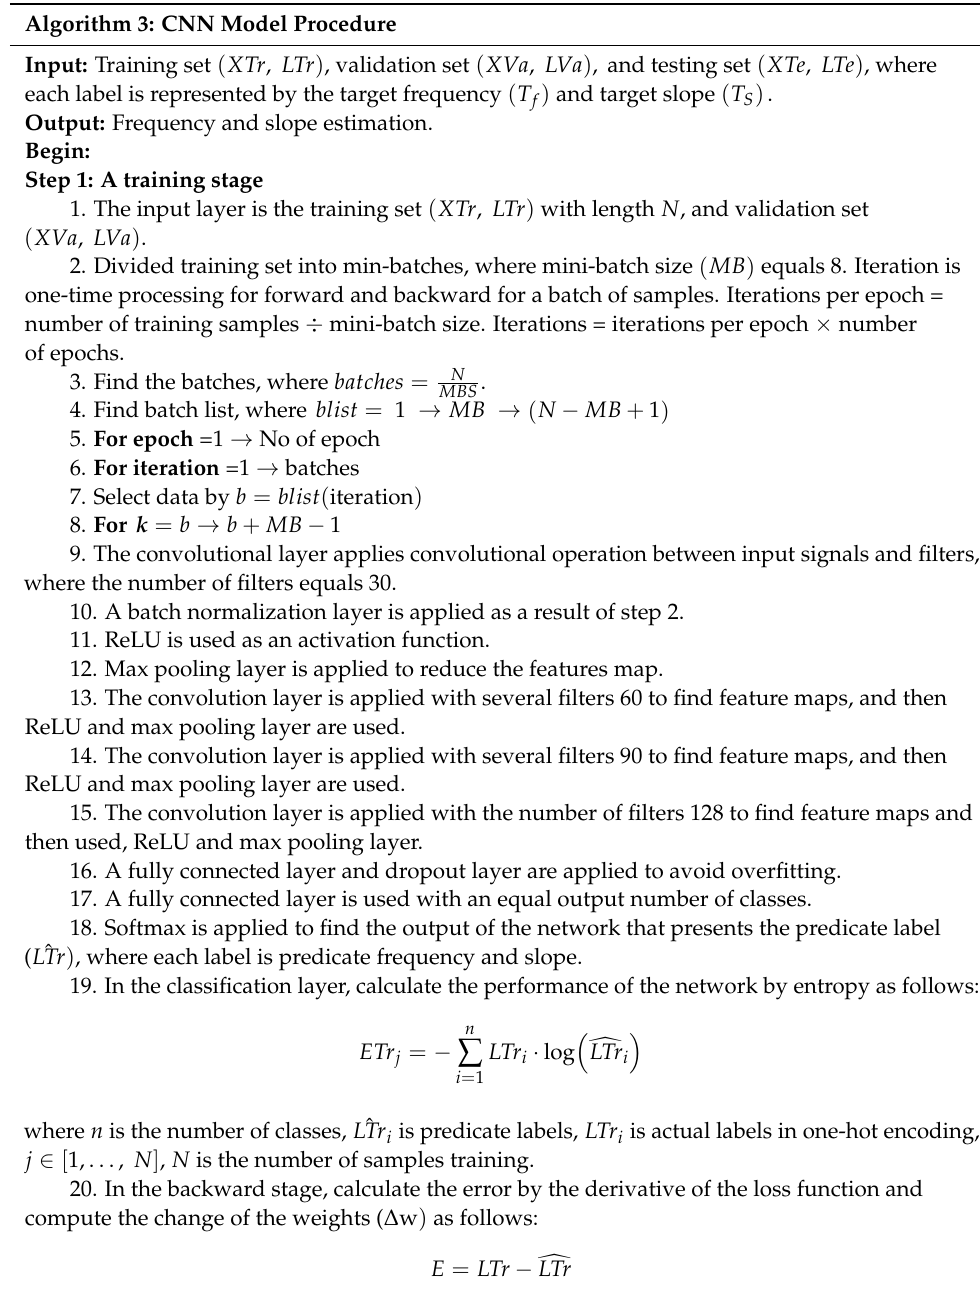
Algorithm 3: CNN Model